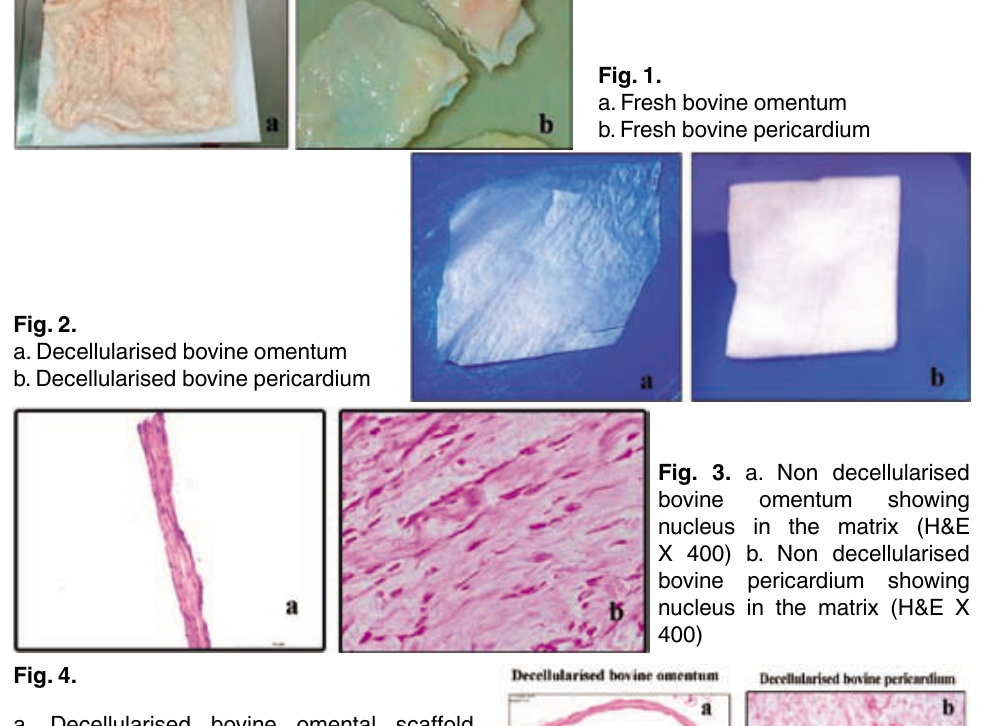
Fig. 4. a. Decellularised bovine omental scaffold showed pink coloured cytoplasm with absence of nuclear remnants (H&E X 400) b. Decellularised bovine pericardial scaffold showed pink coloured cytoplasm with absence of nuclear remnants c. Decellularised bovine omental scaffold showed parallel collagen pattern with absence of nuclear remnants (Masson’s Trichrome X 400), d. Decellularised bovine pericardiual scaffold showed parallel collagen pattern with absence of nuclear remnants (Masson’s Trichrome X 400),e. Decellularised bovine omental scaffold showed presence of glycosaminoglycans in the decellularised matrix (Alcian blue stain X 400), f. Decellularised bovine pericardial scaffold showing presence of glycosaminoglycans in the decellularised matrix (Alcian blue stain X 400), g. Scanning electron micrograph of decellularised bovine omentum revealed acellular, intact and thick collagen fibers and pores were visible (red arrow)(SEM X 5000) h. Scanning electron micrograph of decellularised bovine pericardium revealed acellular collagen fibers and pores (red arrow) (SEM X 5000)